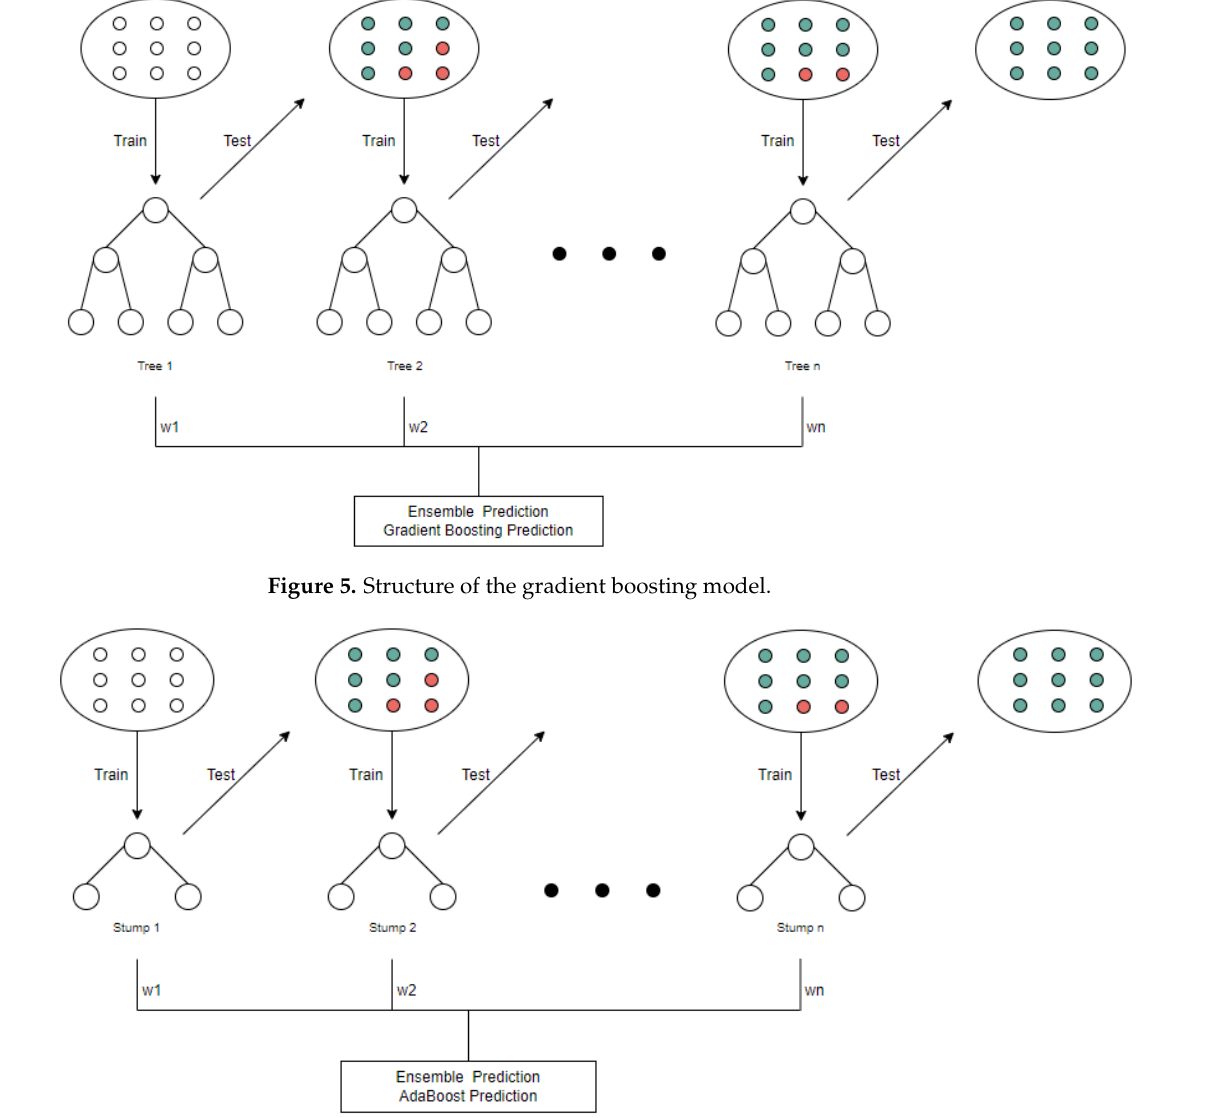
Figure 6. Structure of the AdaBoost